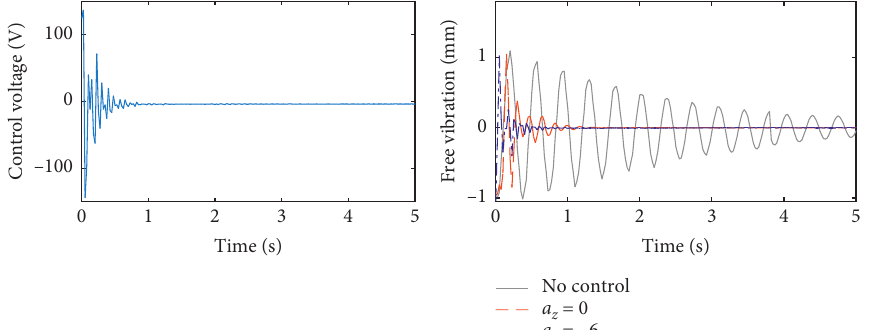
Figure 12: Control result at a